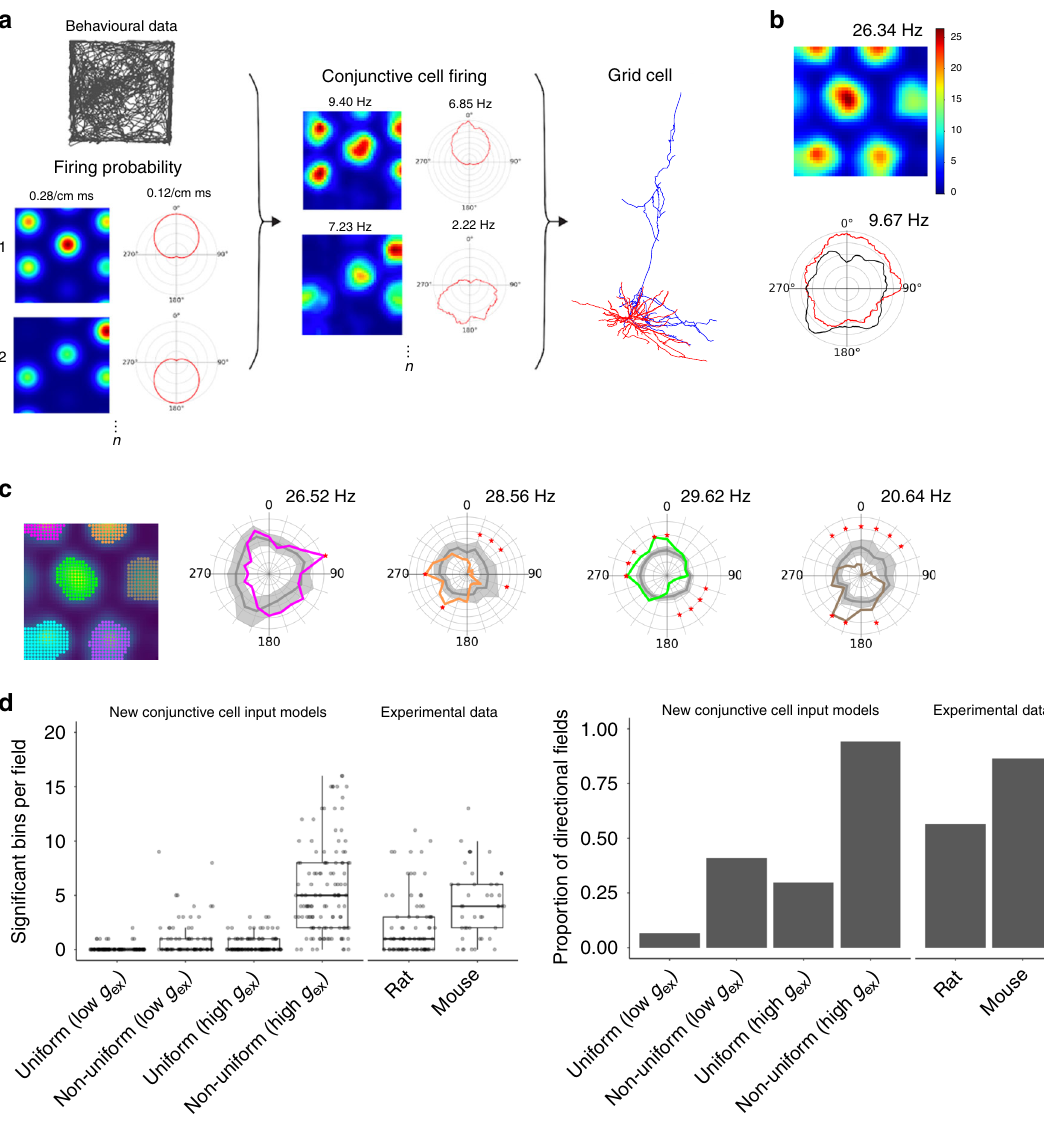
Fig. 7 Integration of non-uniform conjunctive cell inputs accounts for directional modulation. a Rate map and head direction polar histograms of conjunctive cell spike fi ring probabilities (with the peak probability listed above) were convolved with the head direction and position of experimentally tracked mice to generate conjunctive cell fi ring fi elds (peak fi ring rates indicated above). Firing times of the simulated conjunctive cells were used to trigger synaptic input to a compartmental model of a stellate cell. b Representative rate-coded fi ring fi elds and head direction histograms from a simulation with fi ve conjunctive cell inputs. c Directionally binned fi ring rate for selected fi elds colour coded according to the accompanying rate map. Grey lines are the corresponding shuf fl ed distributions. Asterisks indicate bins in which the observed data differs signi fi cantly from the shuf fl ed data ( p < 0.05, two-tailed p value calculated from the shuf fl ed distribution and corrected for multiple comparisons with the Benjamini – Hochberg procedure). d Comparison of conjunctive cell input models with experimental data, showing signi fi cant bins per fi eld (left), and proportion of directional fi elds (right). The number of signi fi cant bins per fi eld in the high conductance (high g ex ) non-uniform model was greater than for the rat data ( p = 5.7 × 10 − 9 , one-way ANOVA with Games – Howell test) but did not differ signi fi cantly from the mouse data ( p = 0.299), whereas the low conductance (low g ex ) non-uniform model had fewer signi fi cant fi elds than the mouse data ( p = 6.1 × 10 − 6 ) but not did not differ signi fi cantly from the rat data ( p = 0.172). Both high- and low-conductance uniform models had fewer signi fi cant bins per fi eld than the mouse data ( p = 7.1 × 10 − 8 and p = 7.1 × 10 − 9 , respectively) and rat data ( p = 1.8 × 10 − 4 and p = 1.3 × 10 − 4 ,